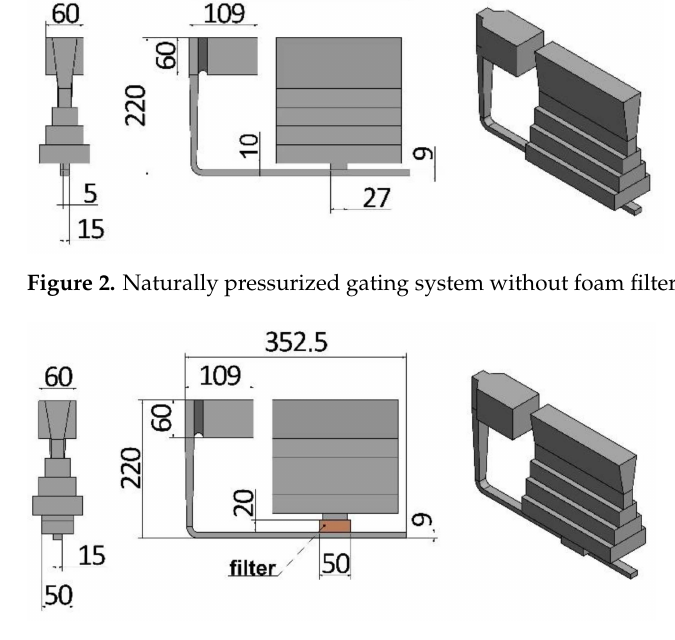
Figure 3. Naturally pressurized gating system with 10 and 20 ppi foam filter.